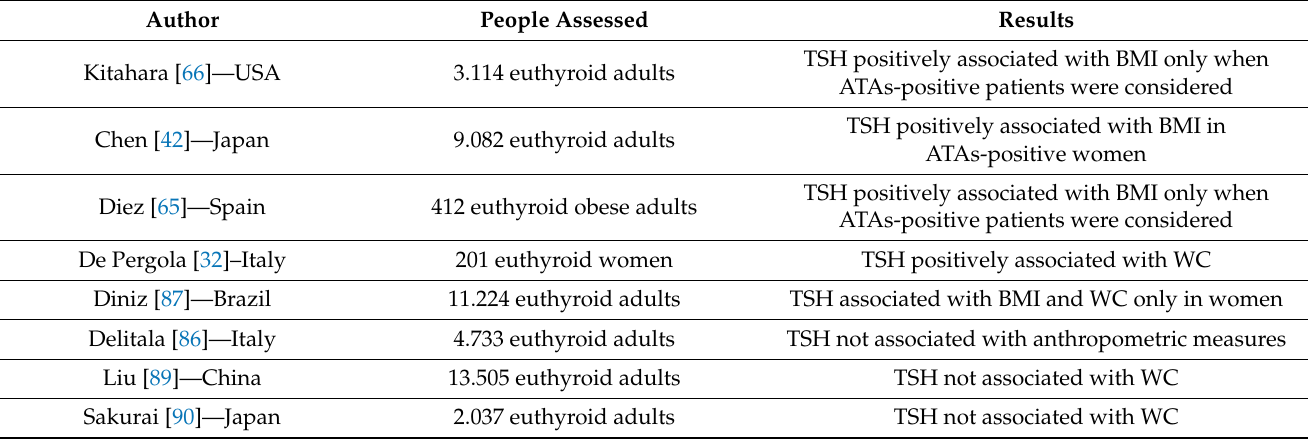
Table 4. Association between anthropometric measures and TSH in euthyroid